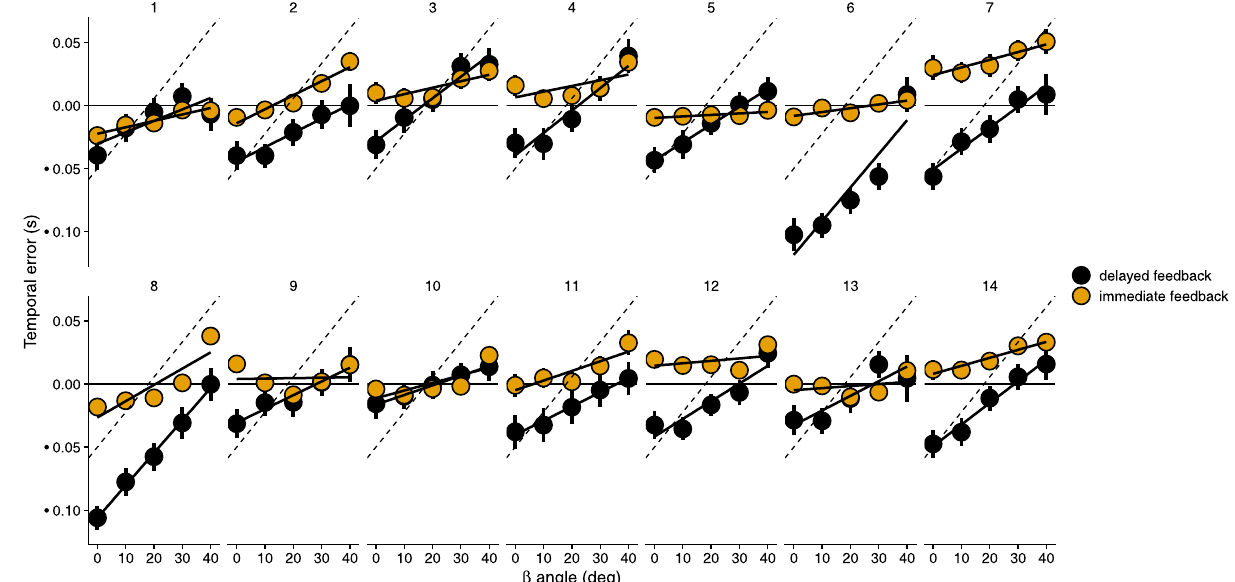
Figure 4. Temporal errors as a function of the β angle for the two conditions (color coded). Each participant is plotted on a different panel. The dashed line indicates the errors participants would make if the differential time it took for the bullet to intersect the target’s path in the delayed feedback condition had been ignored. Negative values denote late